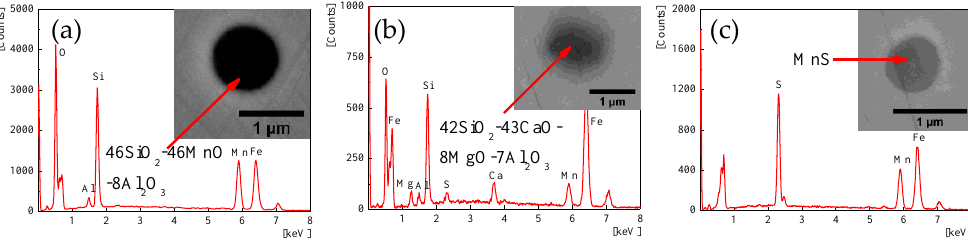
Figure 12. Typical inclusions in steel which were treated by adding Rb 2 O in synthetic refining slag.